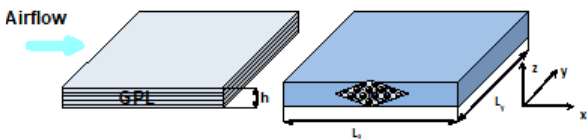
Figure 1: The geometry of the rectangular plate.